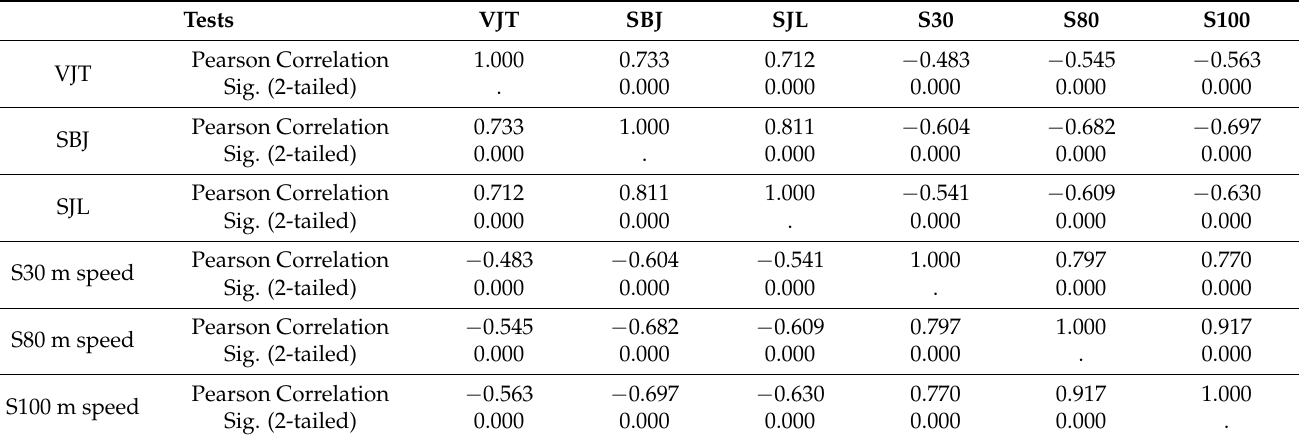
Table 4. Pearson’s correlation between speed and explosive strength abilities according to pre and